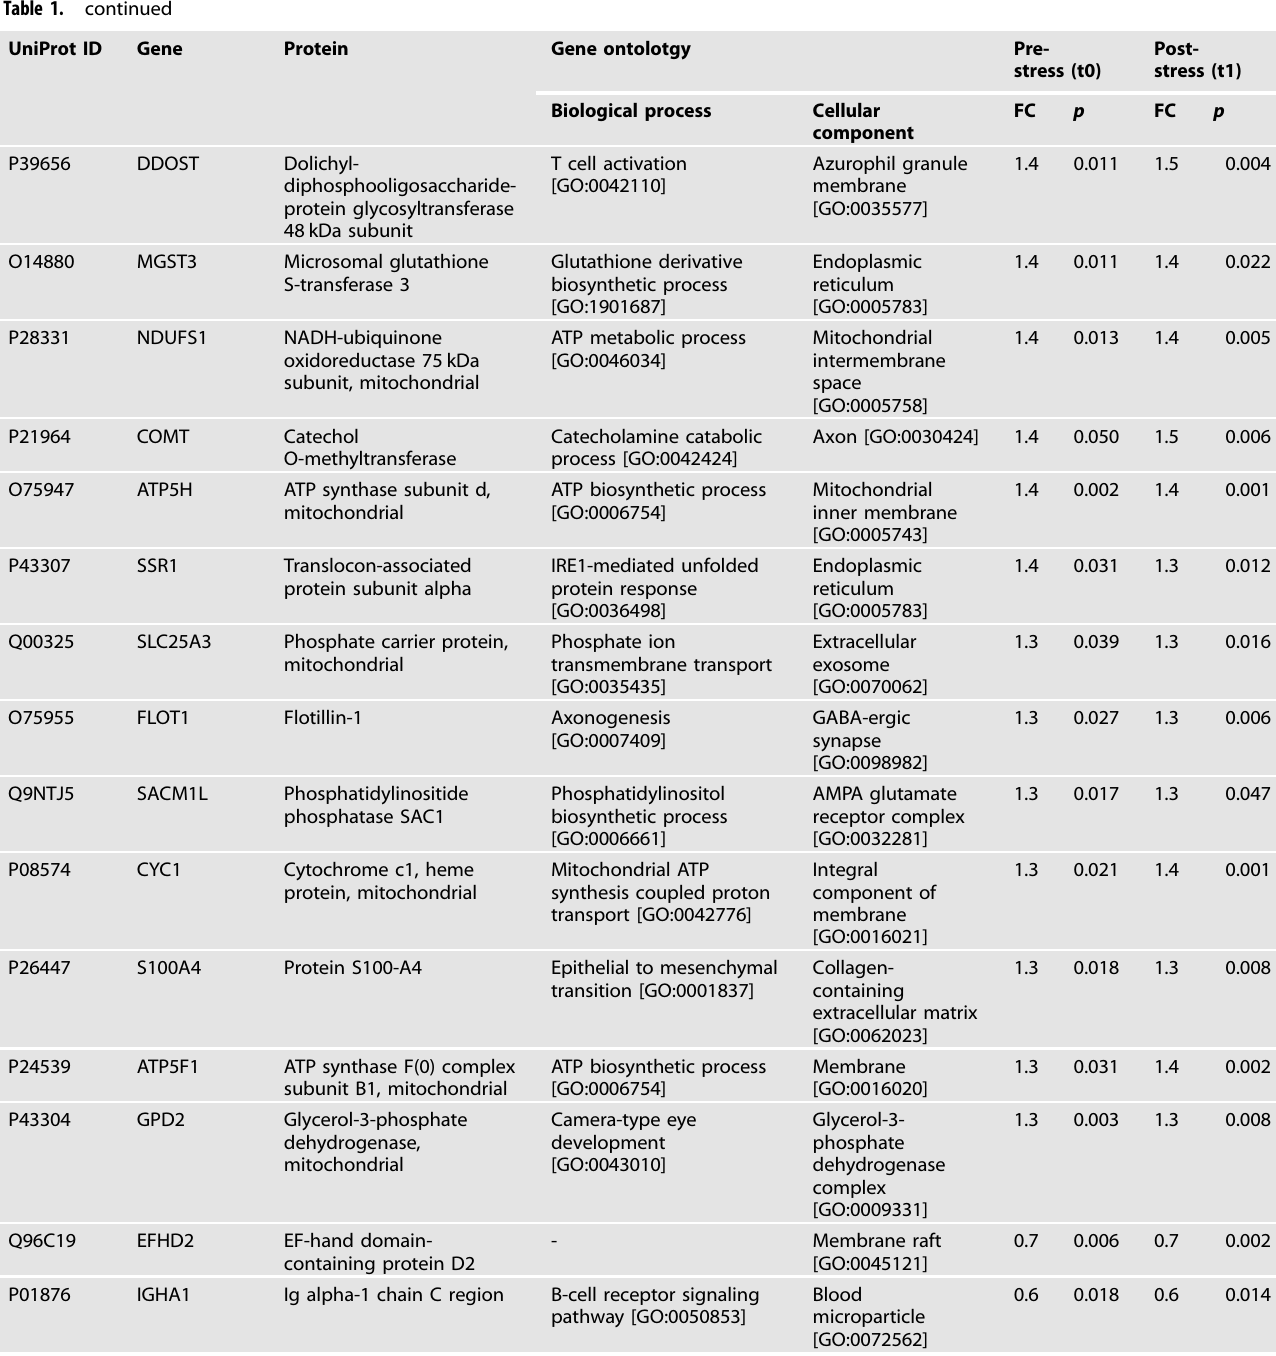
Protein co-expression and stress-related module preservation/